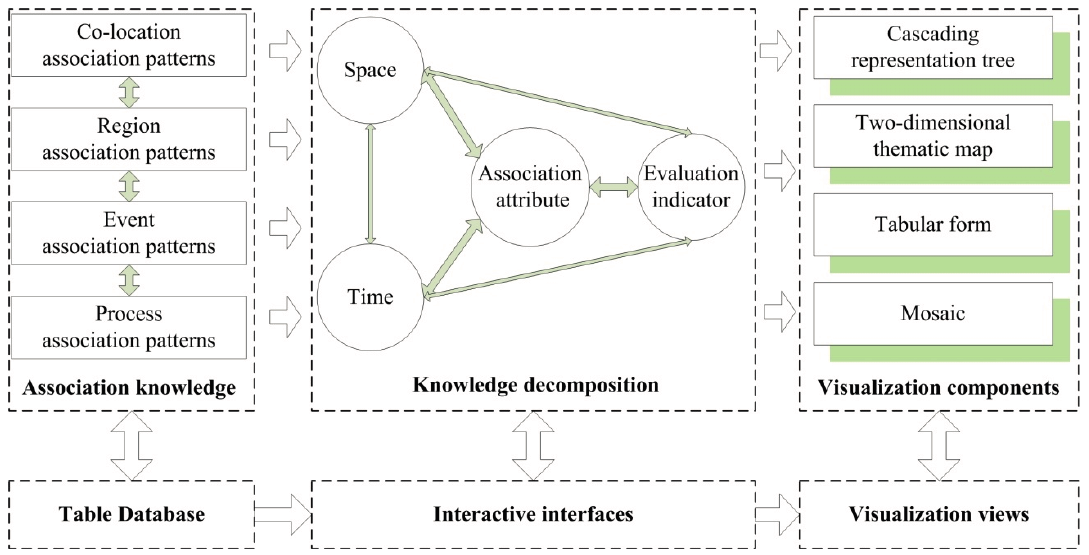
Figure 5. Diagram of the visualization